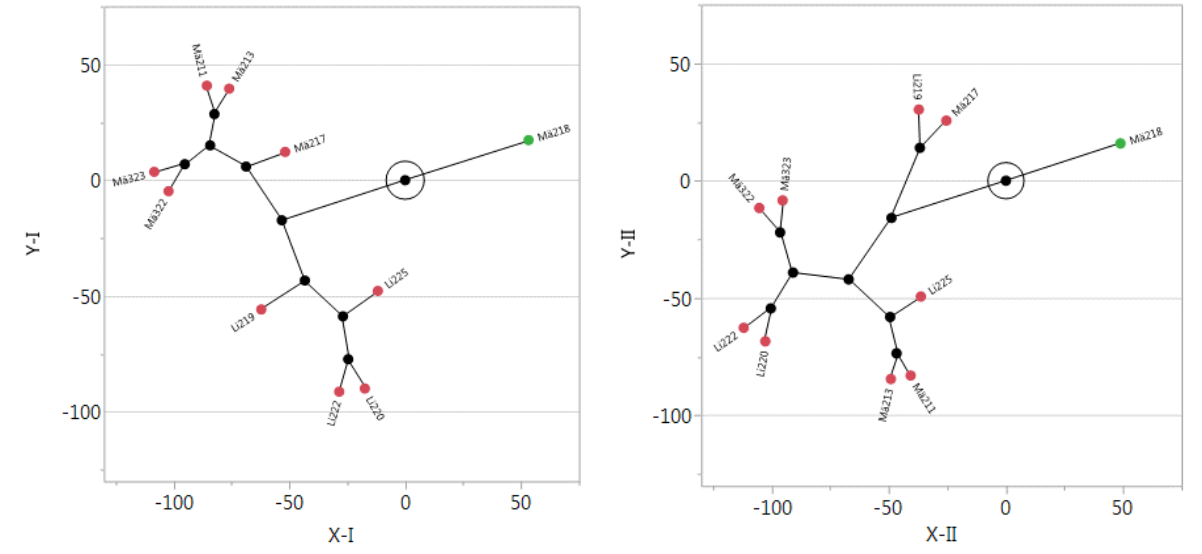
Figure 10. Constellation plots of distance-scaled dendrograms of Period I and II groundwater levels of different Linnusaare (Li) and Männikjärve (Mä) bog ecotopes. In these graphs and later: circled dot = the endpoint of hierarchically clustered data matrix (Ward method), Y and X = the endpoint co-ordinates of clustered variables. Abbreviations for variables as in Table